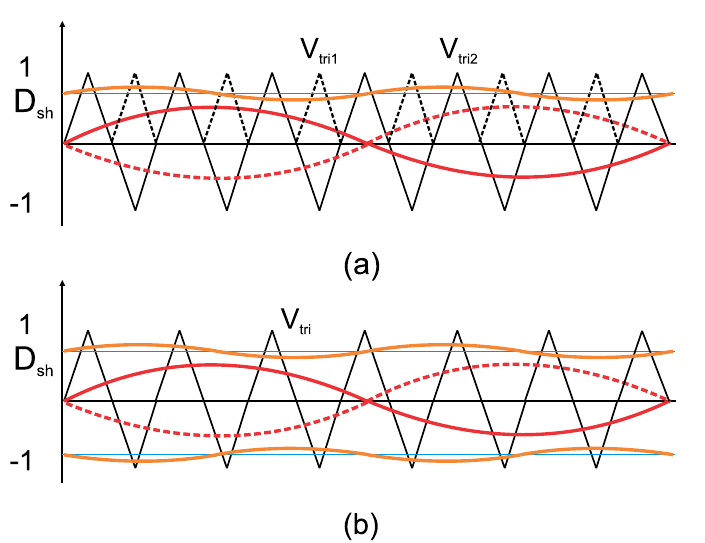
Figure 30. PWM strategy proposed in [130]. ( a ) Positive shoot through duty (in orange)with two triangular repeating waveforms (in black and dotted). ( b ) Positive and negative shoot through duty (in orange) with just one repeating singal (in black triangular), desired output sine wave is shown in